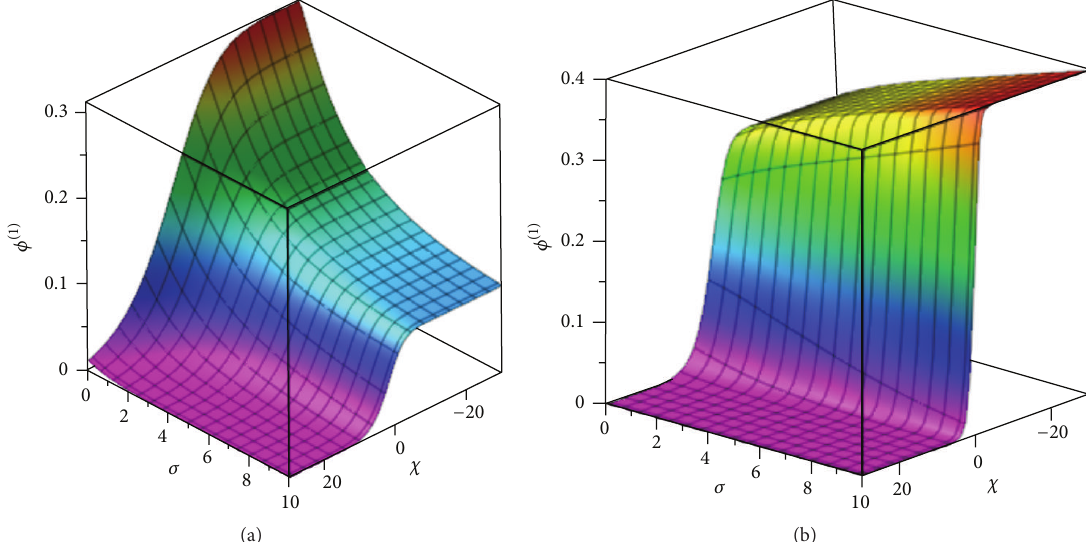
Figure 5: Variation of electrostatic shock waves with respect to 𝜒 and 𝜎 for (a) 𝑞 = 0.4 (superthermality) and (b) 𝑞 = 2 (subthermality) taking the fixed values of 𝛼 = 0.1 , 𝛽 = 0.1 , 𝛿 = 0.01 , and 𝜇 0 = 0.95